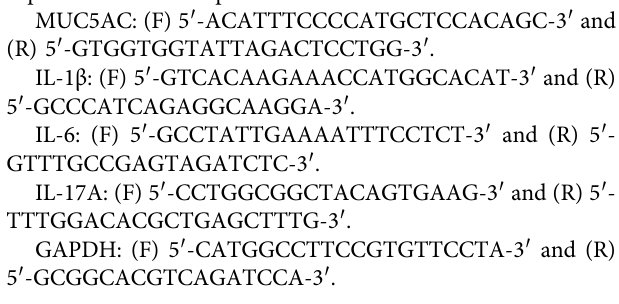
Figure 1A . At the end of the experiment, there was no signi fi cant difference in the body weight between the groups ( Figure 1B